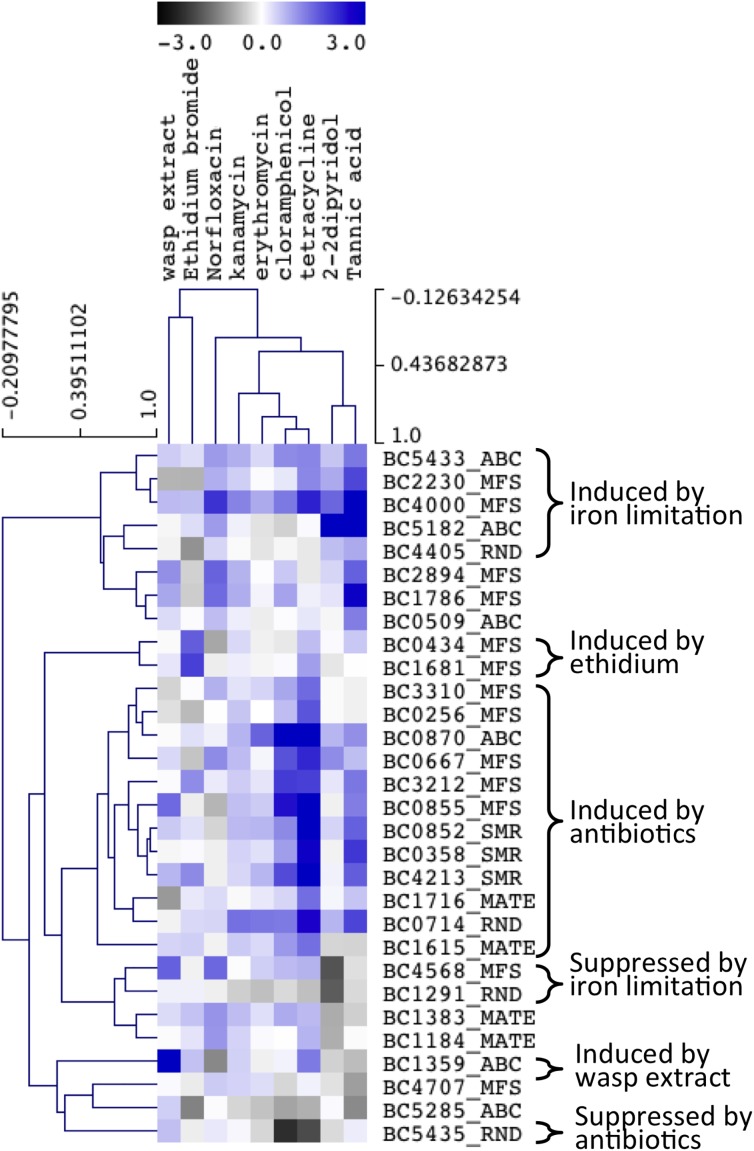
Gene expression changes in response to antimicrobial and environmental shock treatments.Relative efflux pump gene expression levels were examined using qRT-PCR on RNA extracted from B. cereus ATCC 14579 treated with antimicrobial compounds compared with untreated cells. B. cereus ATCC 14579 cells were grown at 30°C in MH broth to OD600 = 0.8 and then treated for 20 minutes with the antimicrobial compounds chloramphenicol, norfloxacin, kanamycin, erythromycin, tetracycline, ethidium bromide, 2,2’-dipyridole, tannic acid and wasp extract, at concentrations corresponding to 50% of the MIC (S3 Table). The BC1744 helicase gene was used as the reference gene to normalize the data. Hierarchical clustering analysis [57] was performed on the average gene expression values using the Pearson correlation method using the TIGR Multi-Experiment Viewer TMEV software [58]. The scale shows log2 fold-changes in gene expression between treated cells and untreated controls.